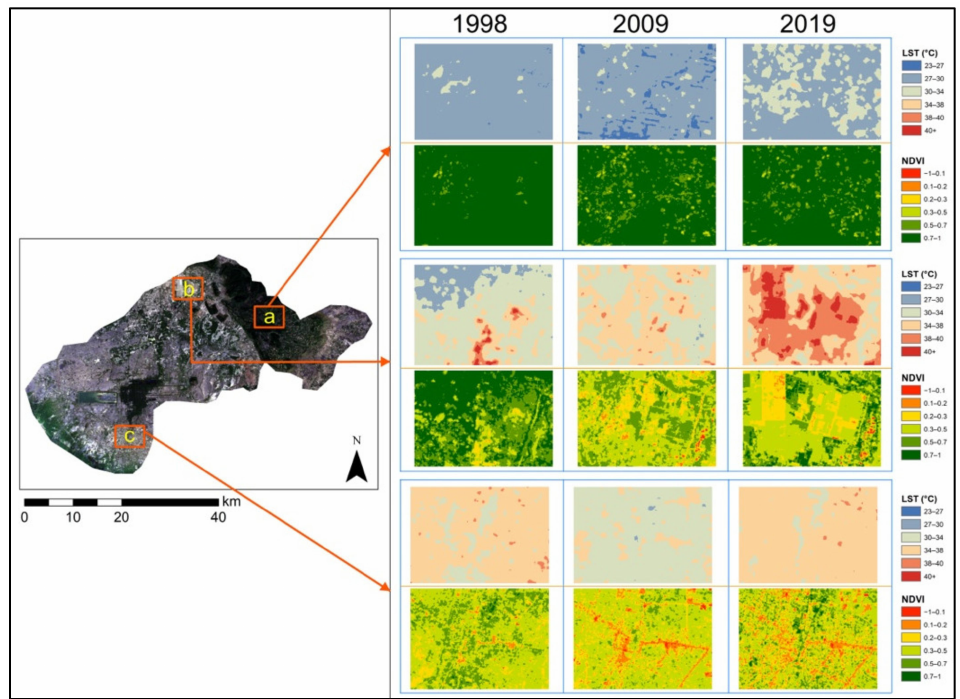
Figure 3. Zoomed in areas to show detailed LST and NDVI data. (a) rural mountains, (b) rural agricultural lowlands, and (c) urban